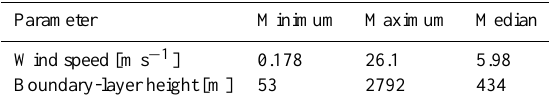
Table 3. Minimum, maximum, and median values of the mean boundary-layer wind speeds and the boundary-layer heights for the training data used in this study.